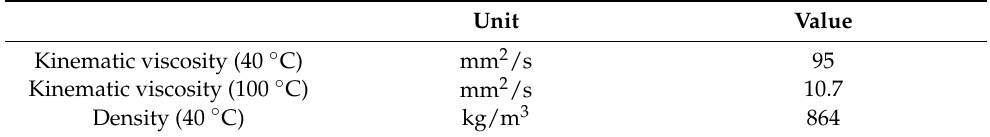
Table 2. Lubricant properties FVA3A.